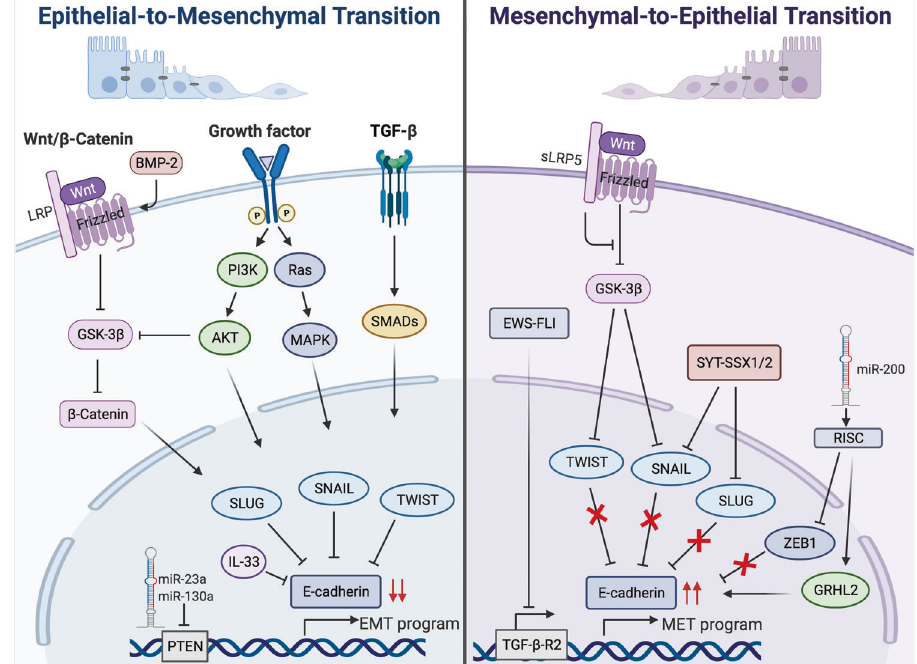
Fig. 5 Factors promoting epithelial-to-mesenchymal transition (EMT) and mesenchymal-to-epithelial transition (MET) in sarcomagenesis